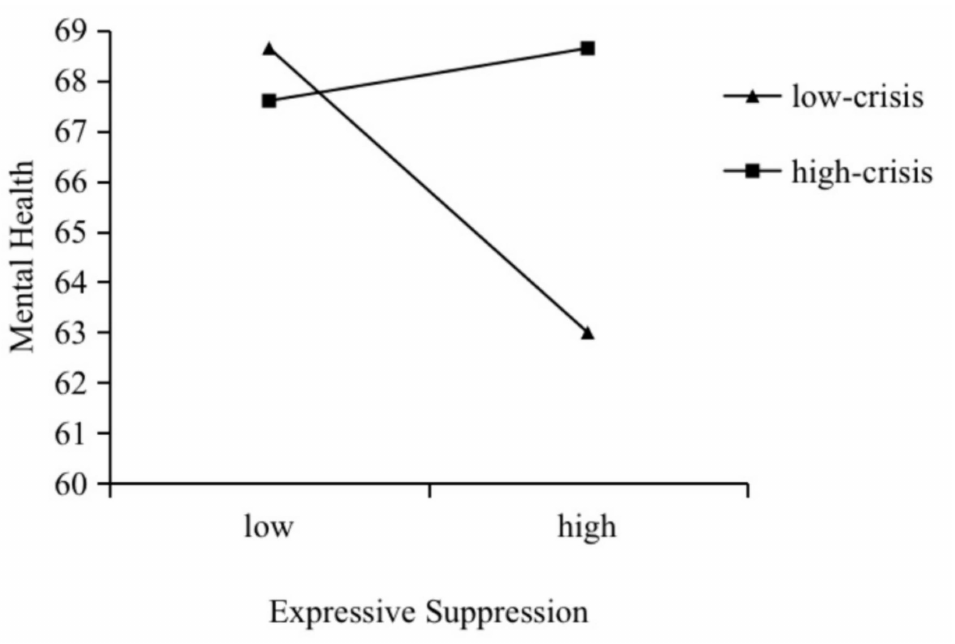
Figure 3. Moderating role of crisis in the relationship between expressive suppression and men- tal